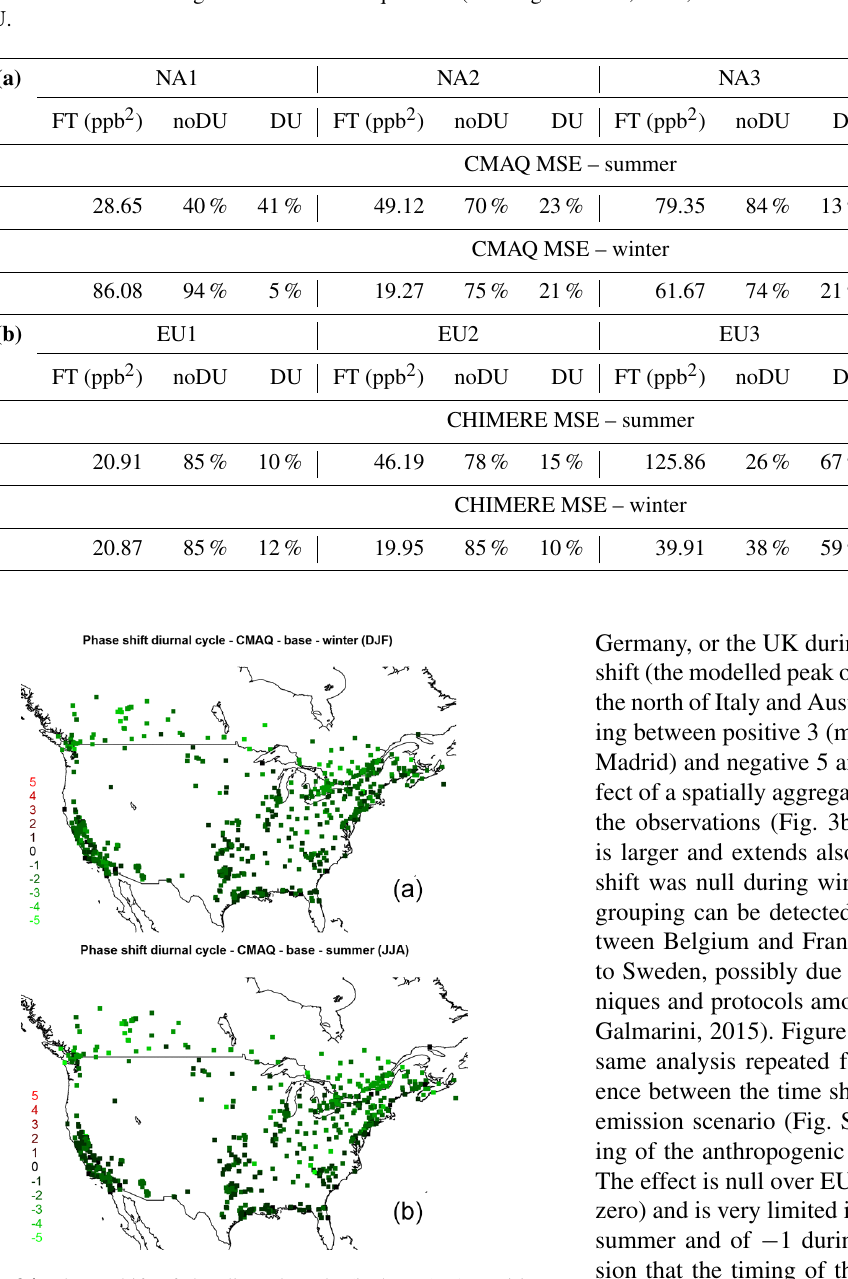
Figure 24. Phase shift of the diurnal cycle (in hours). A positive phase shift indicates that the model peak is “late”, while a negative phase shift indicates that the modelled peak precedes the observed peak. This analysis includes urban and suburban stations in addition to rural